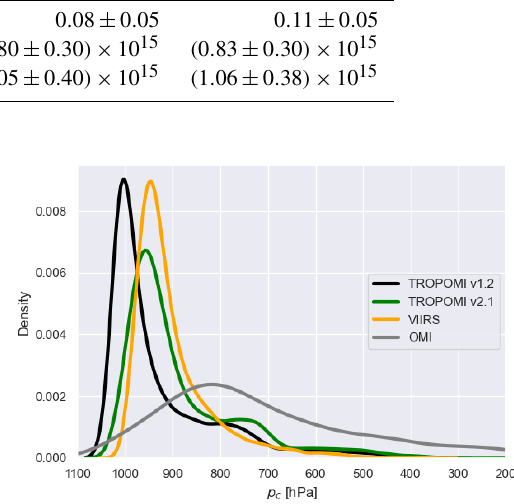
Figure 5. (a) Probability distribution of tropospheric NO 2 columns ( N s , trop /M geo ) over the Central Mediterranean north of Libya in June– July–August 2018 (see grey rectangle in Fig. 1c) taken under non-sun glint, sun glint ( (cid:50) ≤ 30 ◦ ), and super sun glint ( (cid:50) ≤ 20 ◦ ). (b) Proba- bility distribution of tropospheric NO 2 columns in the official TROPOMI NO 2 product ( N s , trop /M trop ) for the same data selection. Table 2. Summary of mean effective scene albedo, normalized tropospheric slant column, and N v , trop for non-sun glint, sun glint ( (cid:50) ≤ 30 ◦ ), and super sun glint ( (cid:50) ≤ 20 ◦ ) over the Central Mediterranean north of Libya in June–July–August 2018 (see gray rectangle in Fig. 1c). Non-sun glint Sun glint